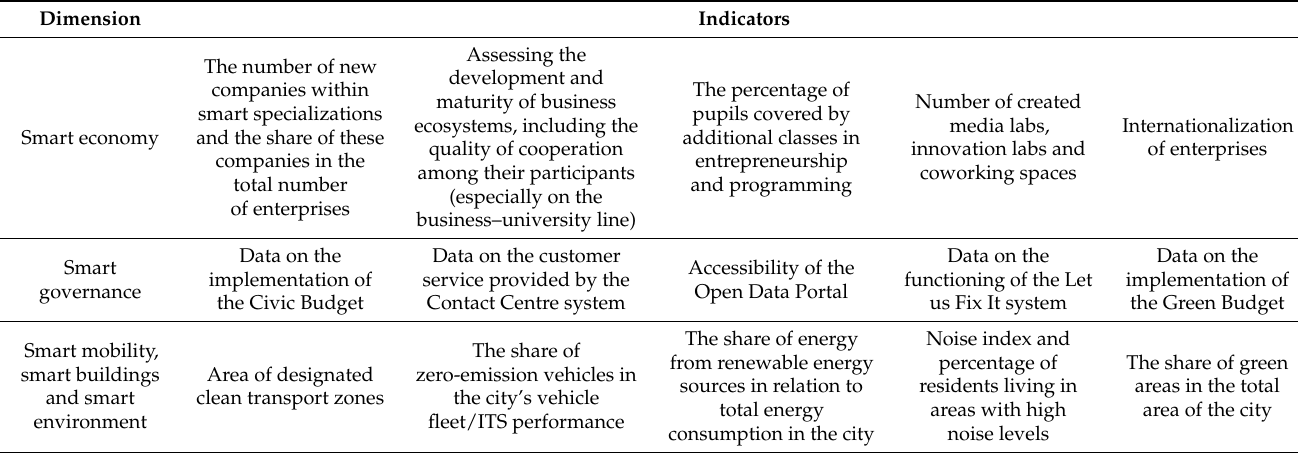
Table 1. Examples of indicators for strategic goals related to selected smart city dimensions included in the Lublin 2030